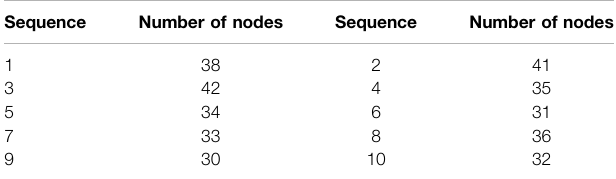
TABLE 4 | The node ’ s ef fi ciency contribution sorting